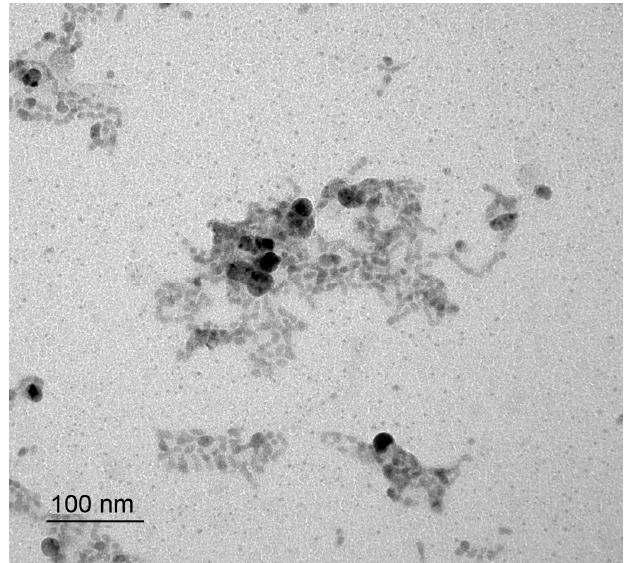
Figure 13. TEM image of synthesized colloid solution of nanoparticles Ag 2 S.